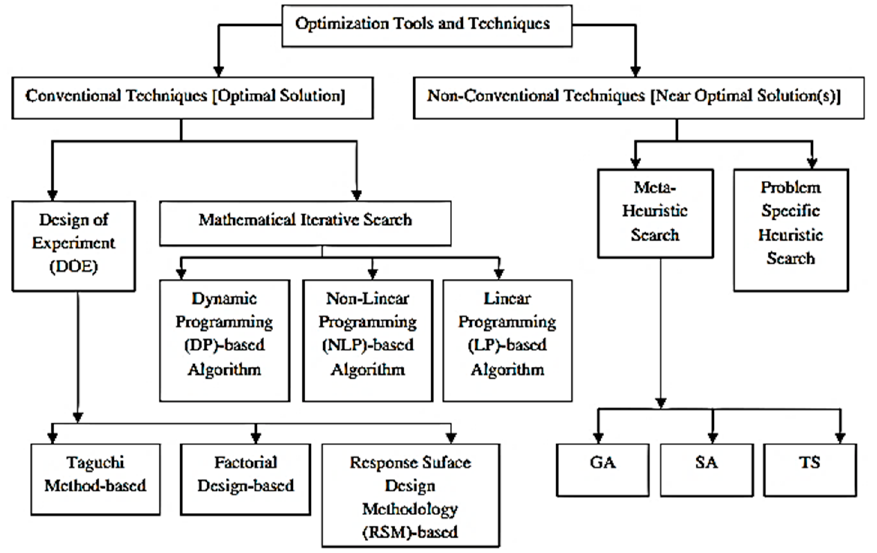
Figure 16. Conventional and non-conventional optimization tools and techniques [88].